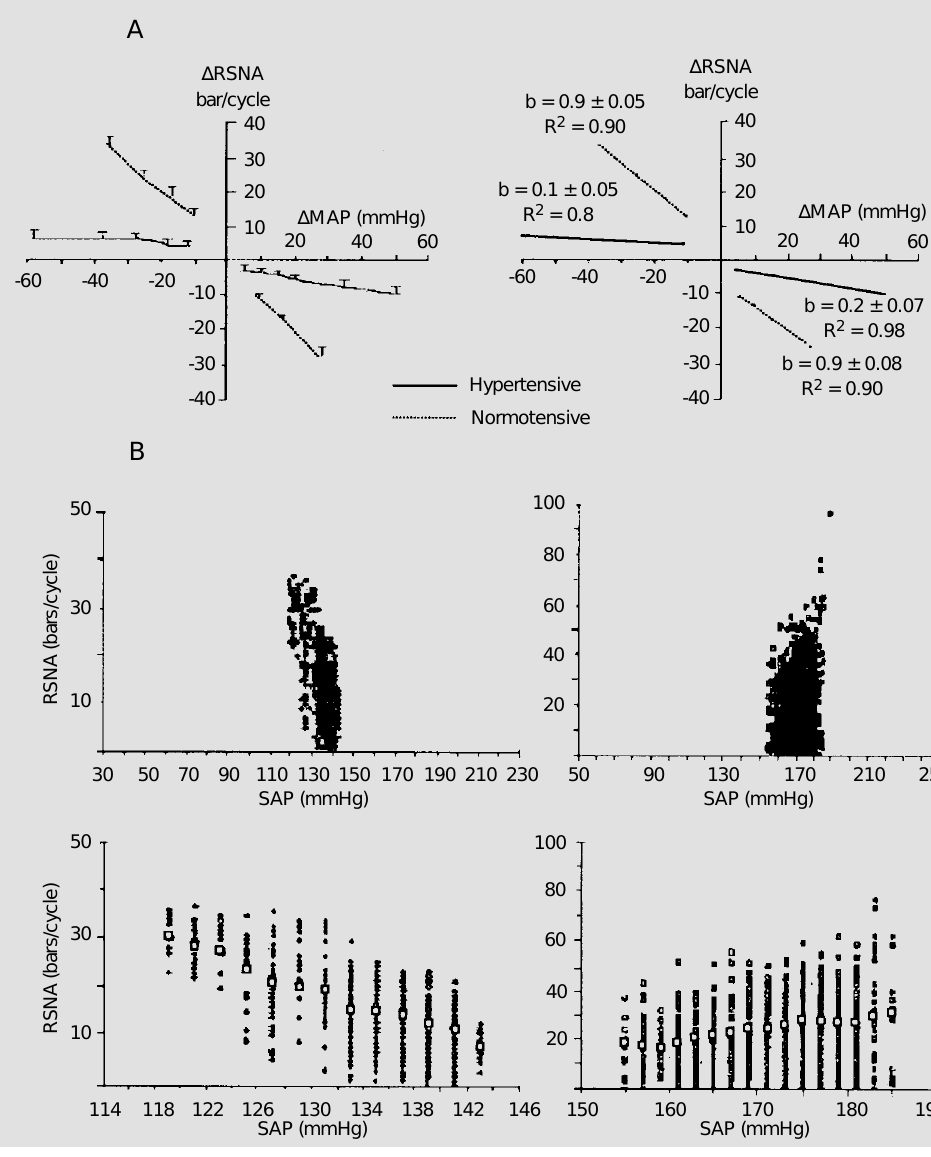
Figure 3 - A , Effects of high-re- nin hypertension on the sympa- thoinhibitory and sympathoexci- tatory responses to pressor changes induced by vasoactive drugs. On the left, actual values of reflex inhibitory responses (lower right) and reflex excita- tory responses (upper left). On the right, regression lines. Solid straight lines: hypertensive rats. Dashed lines: normotensive rats (from Ref. 42). B , Scatterplot showing a spontaneous relation- ship between systolic arterial pressure (SAP) and renal sympa- thetic nerve activity (RSNA) ob- tained from a normal rat (left) and from a high-renin hyperten- sive rat (right). The open plots in the middle of the figures repre- sent averaged RSNA in each class of systolic